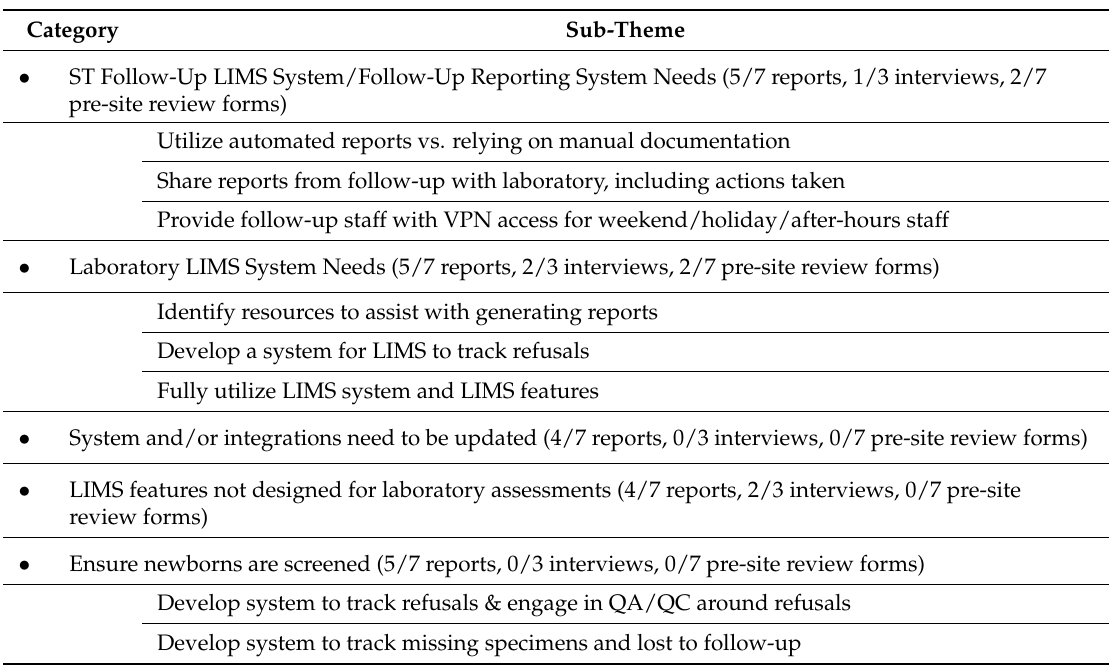
Table 4. Needs identified in State Newborn Screening Program Site Reviews: Information System and Information Technology Needs themes identified (Number of times reported in site review report, individual interview, and pre-site review